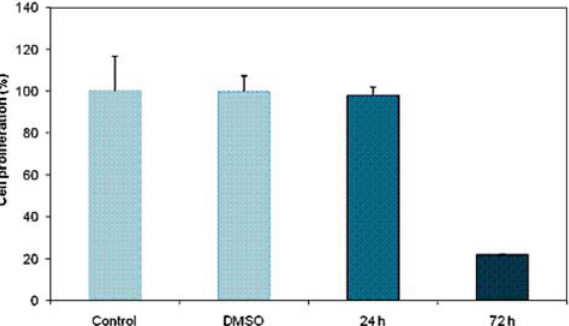
Fig. 1. Effect of the compound 2 (100 μM) on the proliferation of WERI-Rb1 after 24 h and 72 h of treatment